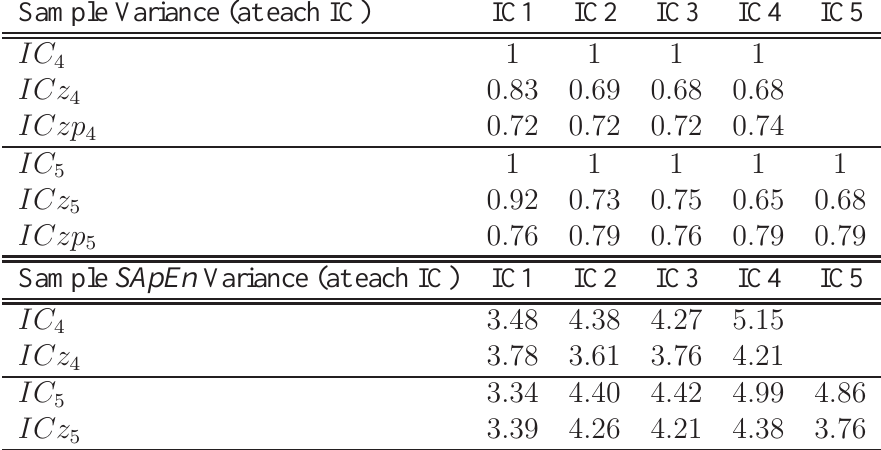
Table 9: Sample Variances (top) and Entropy Variances (bottom) for each IC. The subscript ( . ) 4 or ( . ) 5 indicates the number of components in the system. The symbol zp stands for the perturbed z-scores. Only the case m = 1 is